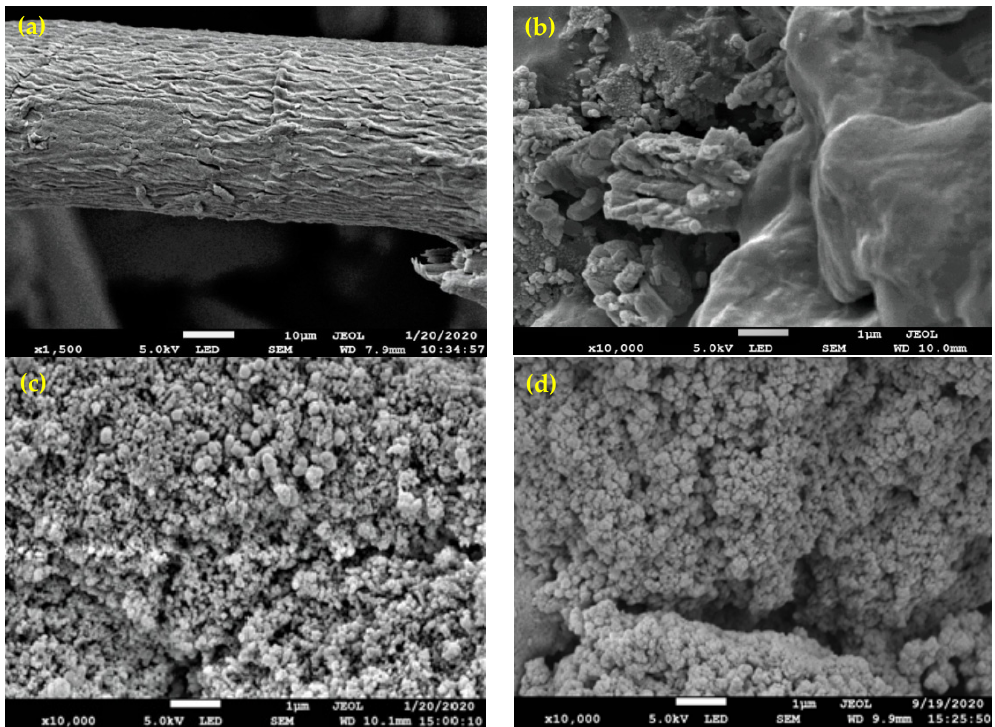
Figure 3. FE-SEM micrograph of ( a ) pure cellulose, ( b ) poly(methyl acrylate)-grafted cellulose, ( c ) poly(hydroxamic acid), and ( d ) poly(hydroxamic acid) ligand-copper complex.